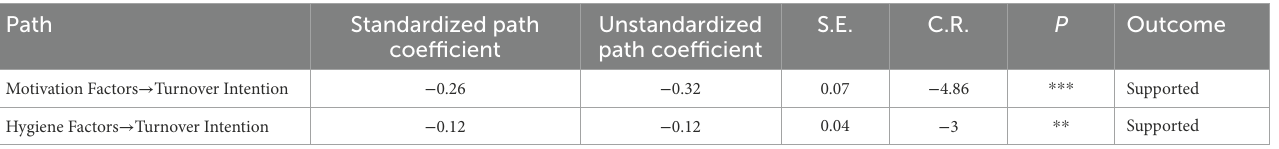
TABLE 5 Structural model path